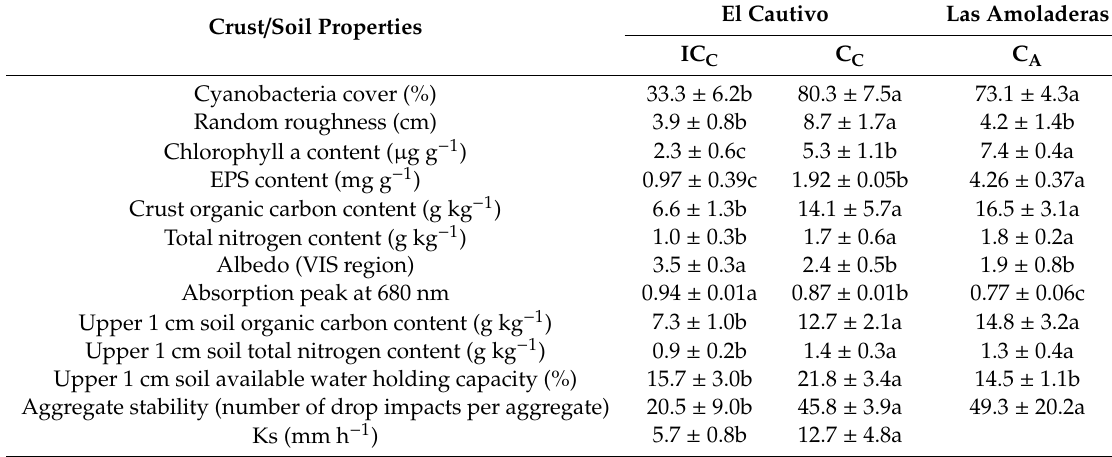
Table 1. Characteristics of the cyanobacterial biocrust types and underlying soils. Di ff erent letters indicate significant di ff erences between the three cyanobacterial biocrust types (p < 0.05).